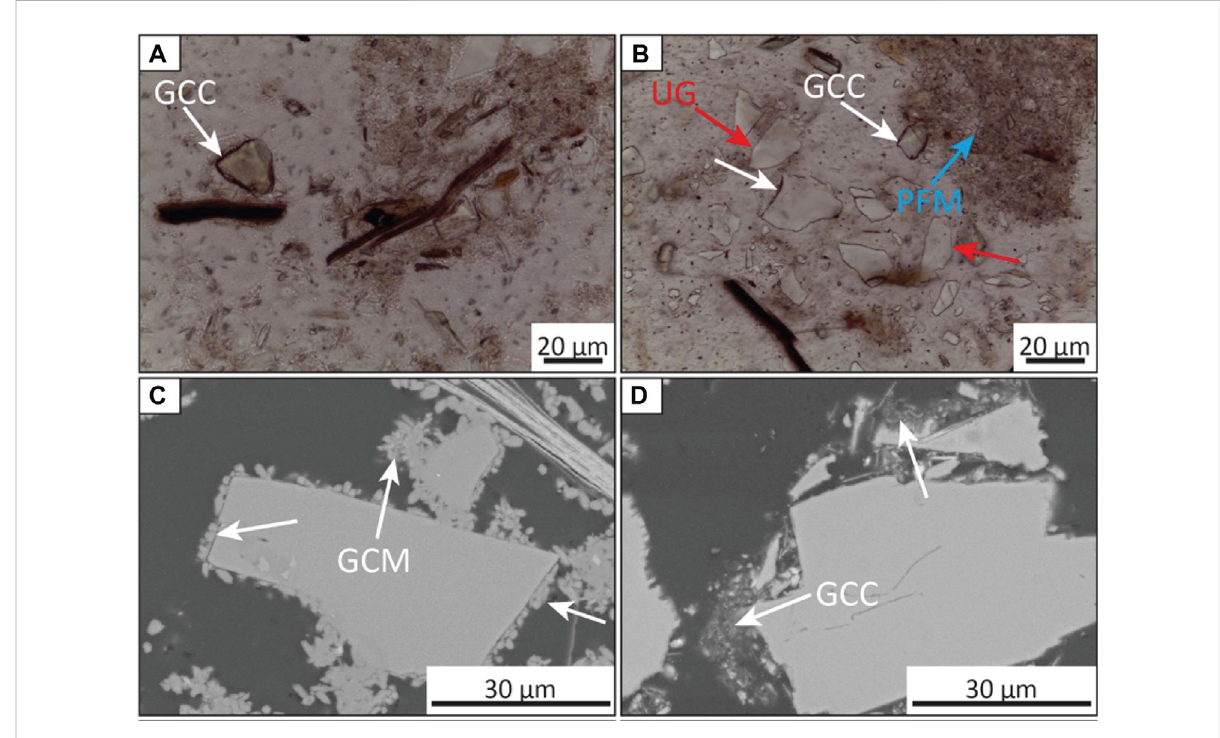
FIGURE 7 Thin-section photomicrographs and BSE images of the reacted samples from Station 036. (A,B) Photomicrographs of the reacted Sample 5 showing grain-coating chlorite (GCC), uncoated grains (UG), and pore- fi lling microcrystalline quartz (PFM). (C) BSE image showing well- developed, grain-coating microcrystalline quartz (GCM) in the silica-reacted Sample 5. (D) BSE image showing grain-coating chlorite (GCC) preventing quartz cementation in the reacted Sample 6. (BSE, Backscattered